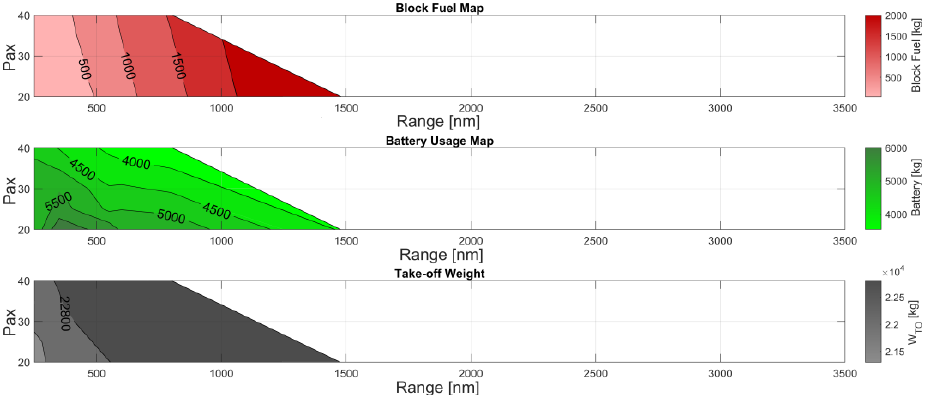
Figure 21. Fuel, battery and take-off mass trends in the whole pax – range diagram ( Φ ice limited ).